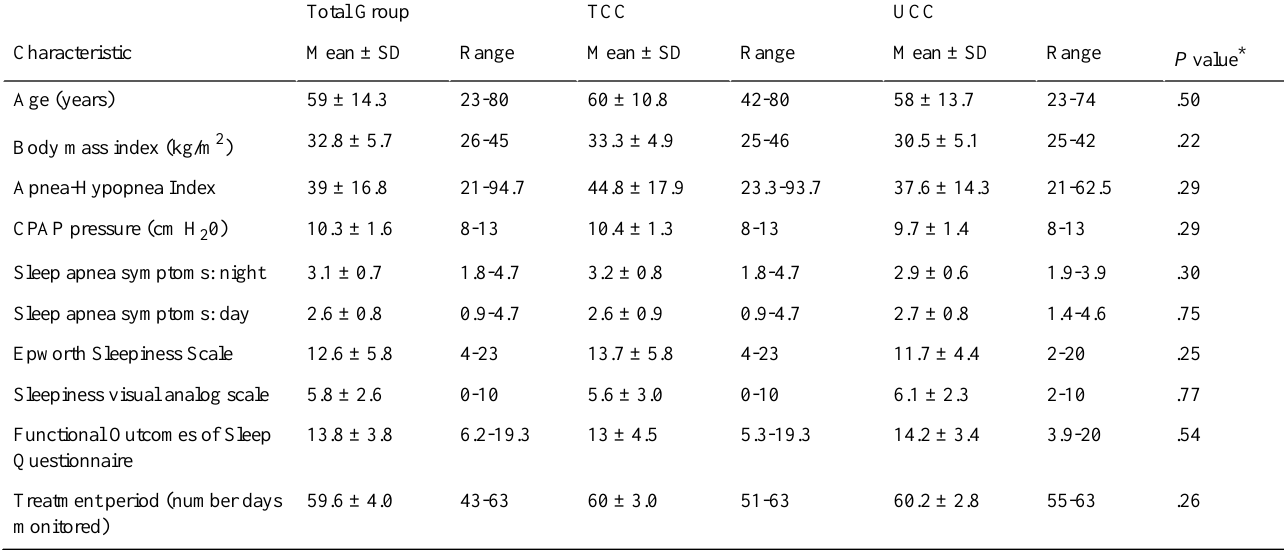
Table 4. Baseline patient characteristics and treatment period, by study arm UCCTCCTotal